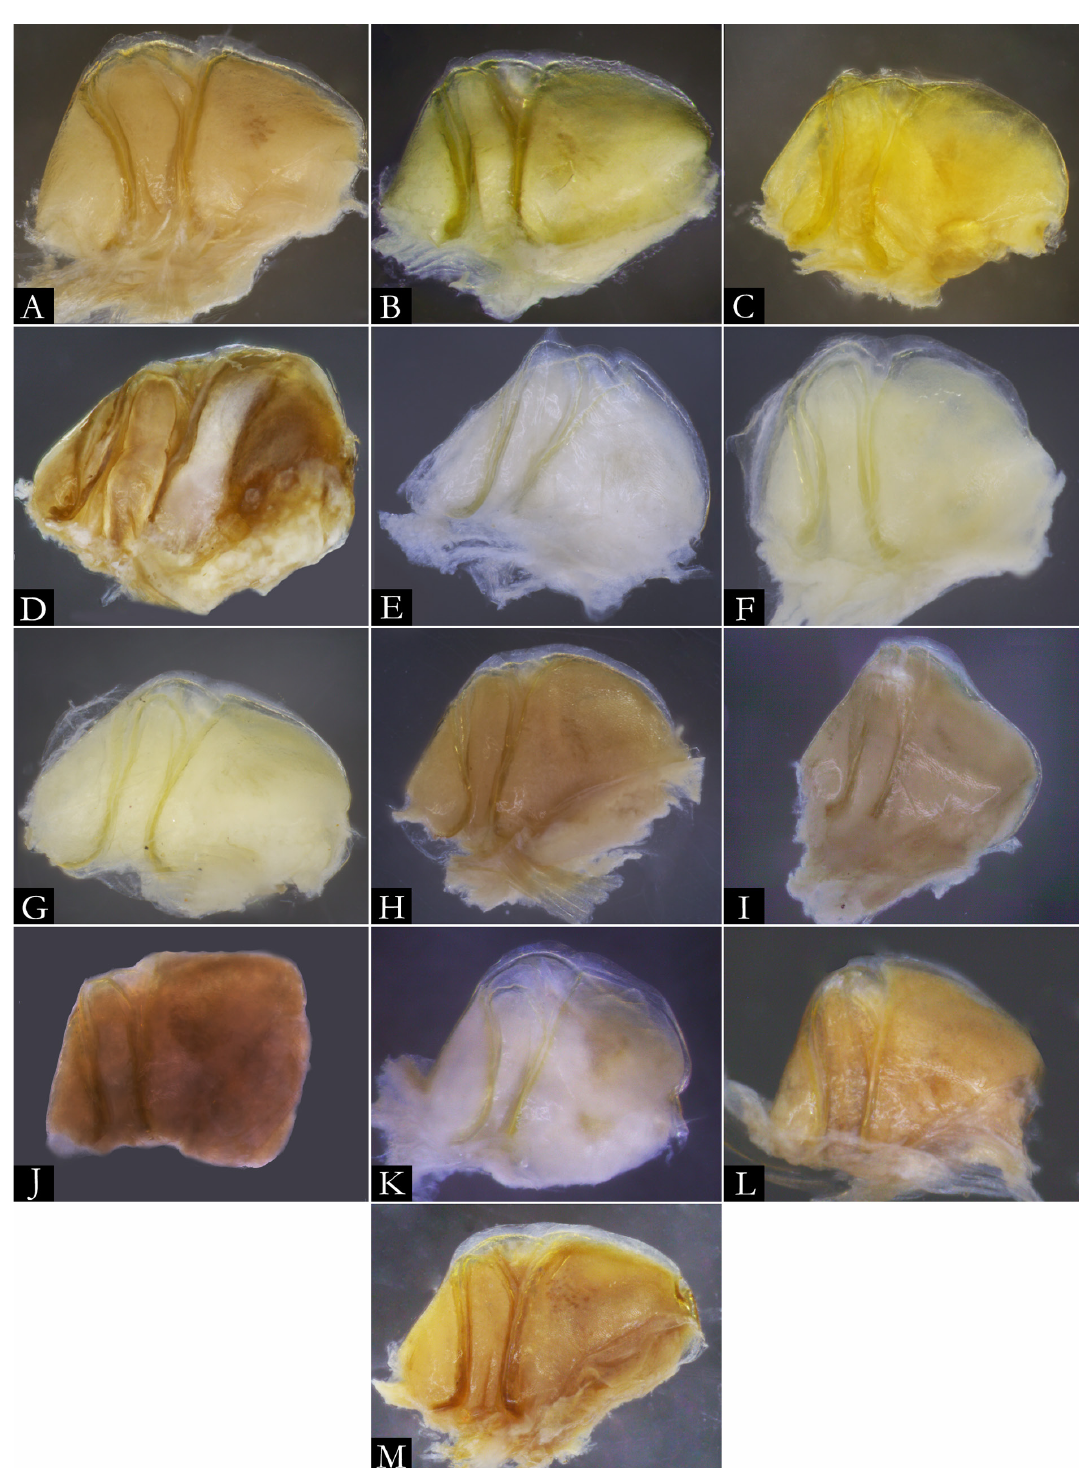
Fig. 179. Stereoscopic images of left vulva of species of Pseudonannolene Silvestri, 1895, in oral view. A . P. strinatii Mauriès, 1974. B . P. tocaiensis Fontanetti, 1996. C . P. tricolor Brölemann, 1902. D . P. typica Silvestri, 1895. E . P. xavieri Iniesta & Ferreira, 2014. F . P. bucculenta sp. nov. G . P.